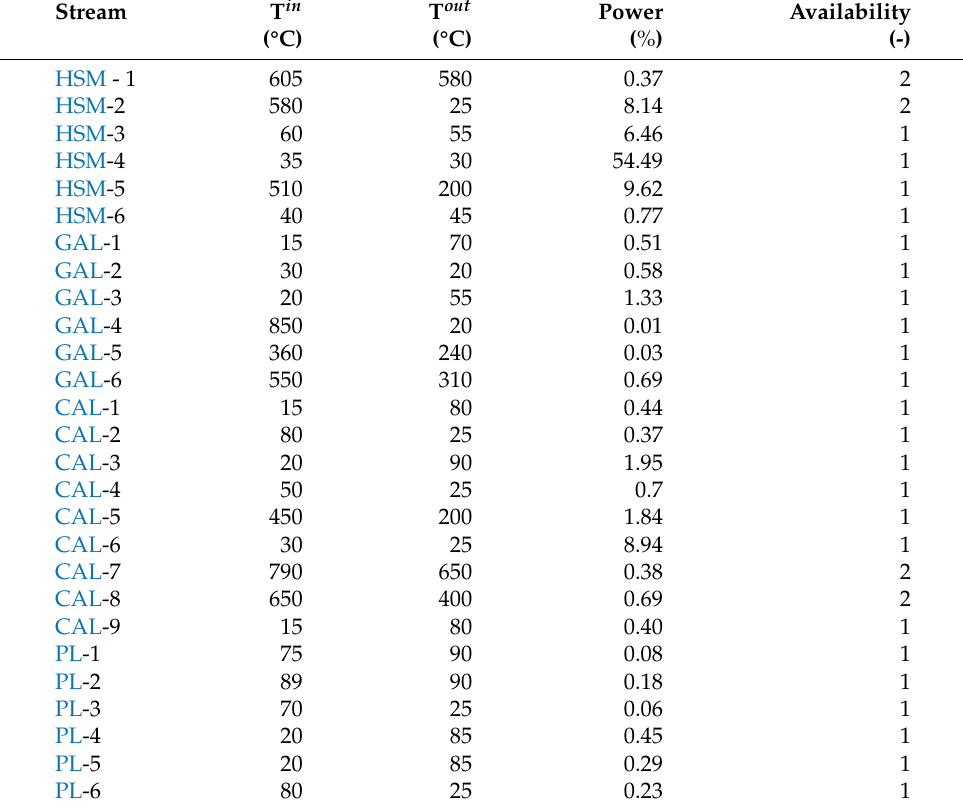
Table 1. Stream table for all